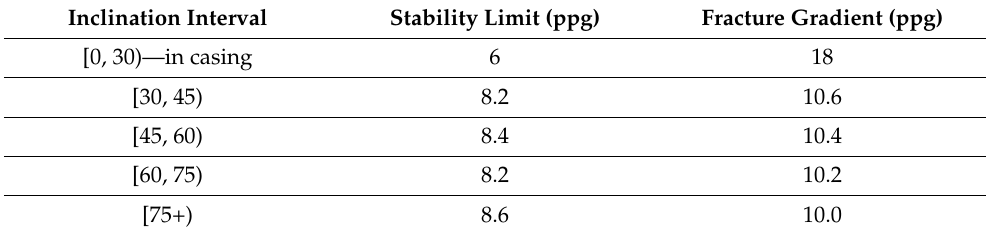
Table 1. The SL and FG values for the different inclination intervals.